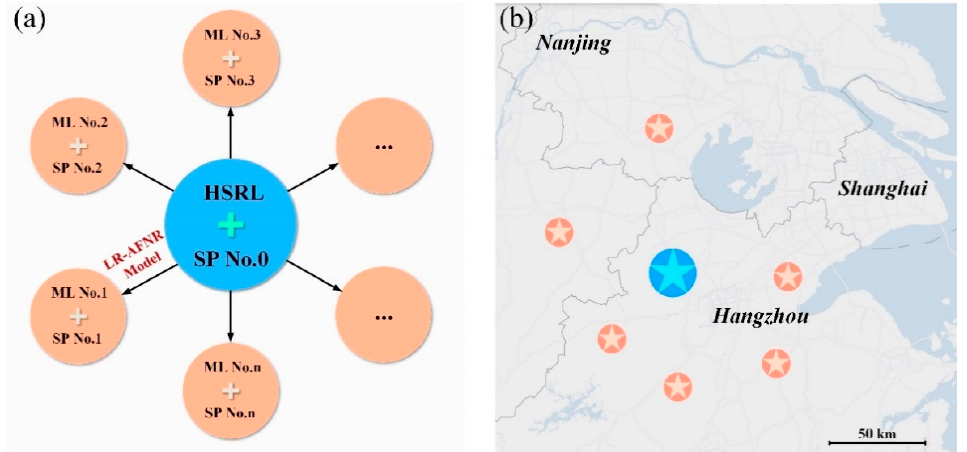
Figure 1. The schematic diagram of the lidar ratio regional transfer method and the spatial distribution of the lidar network. ( a ) The schematic diagram of the lidar ratio regional transfer method. The blue circle in the figure represents the combination of HSRL and the sun photometer (SP) at the same position, and the orange circle represents the combination of ML and the sun photometer (SP) at the same position. The direction of the arrow represents the lidar ratio transfer from HSRL to different MLs using the LR-AFNR. No. 0-n represents the instrument number (n ≥ 1); ( b ) Schematic of the spatial distribution of the lidar network of HSRL combined with MLs. The blue and orange pentagons correspond to the two combinations of the lidar and sun photometer mentioned in figure ( a ).